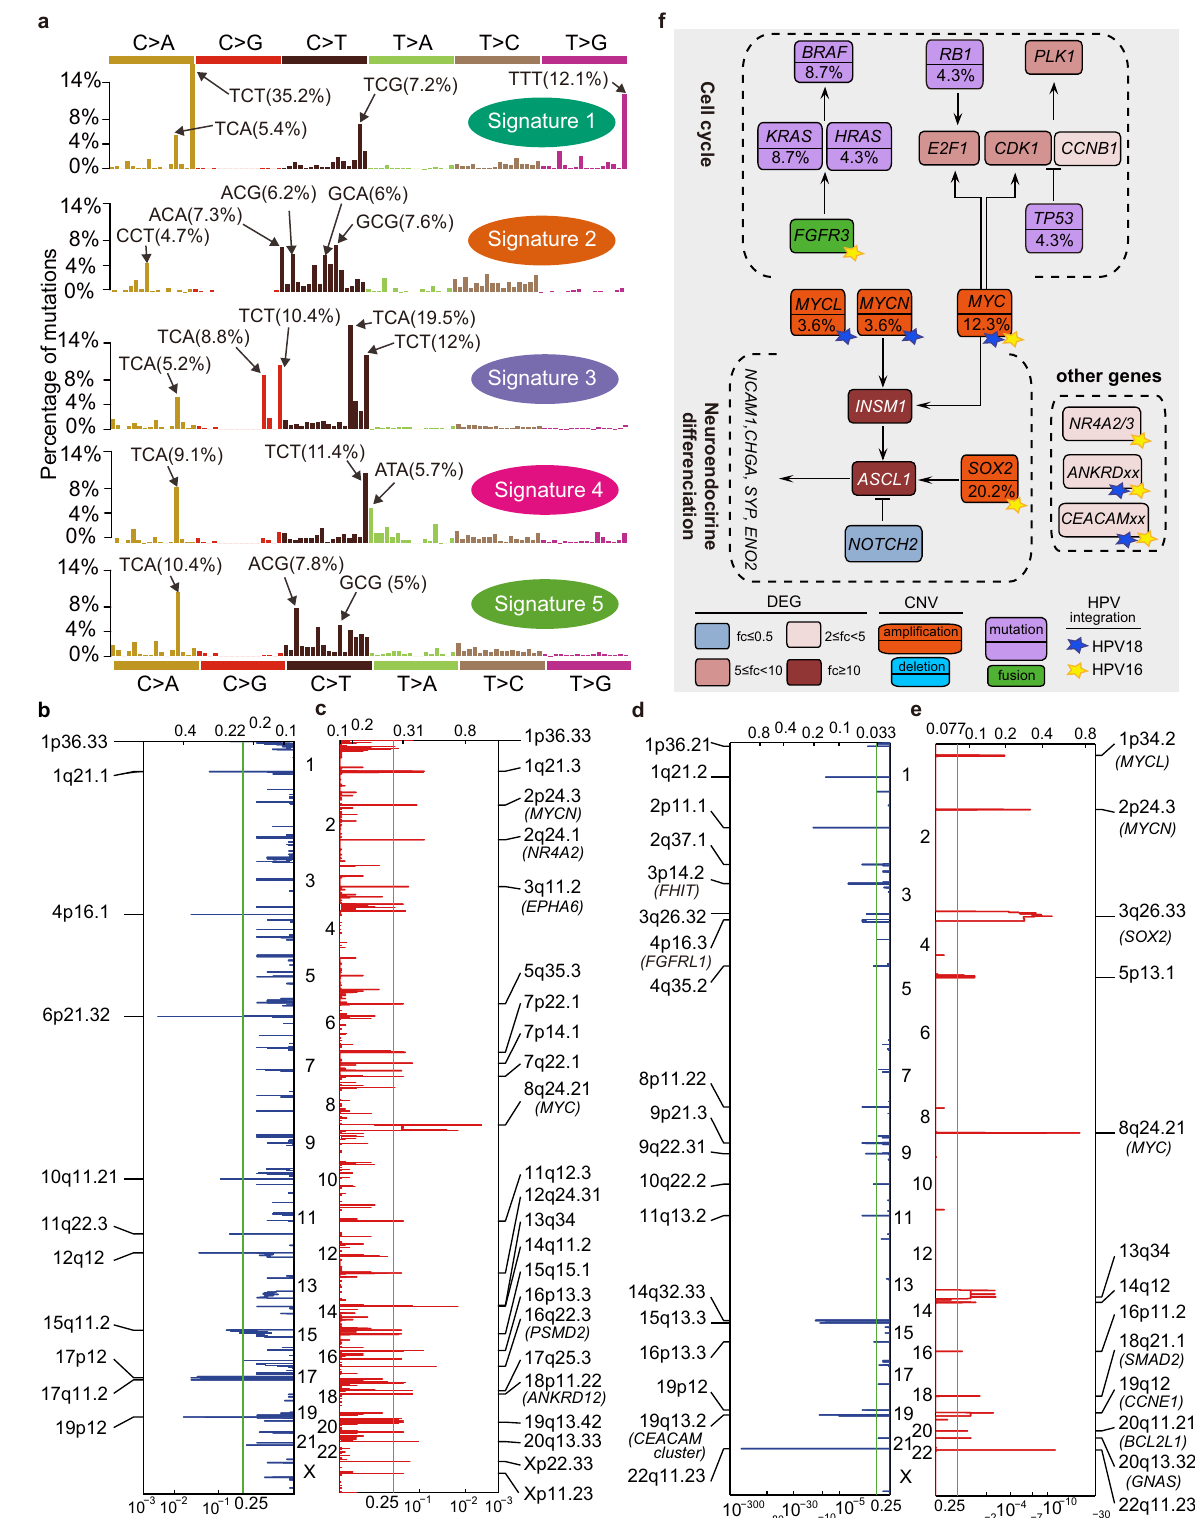
Fig. 4 | Signaling pathways in SCCC. a Five mutational signatures extracted from SCCC. b , c Focalampli fi cation and deletionof copy number alterations of 16 SCCC samples revealed by GISTIC2 algorithm. Signi fi cant peaks and altered genes were displayed. d , e Focal deletion and ampli fi cation peaks of copy number alterations